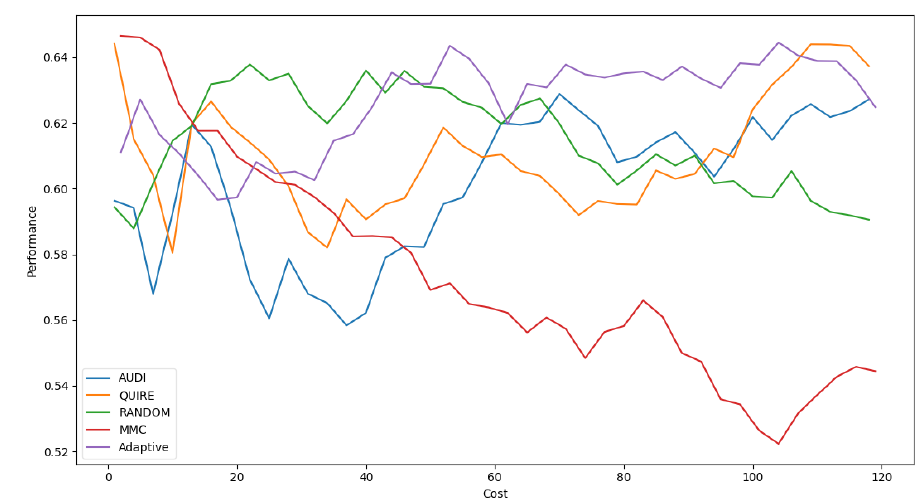
Figure 7. F1-measure for the five selection AL strategies without grid search optimizer.